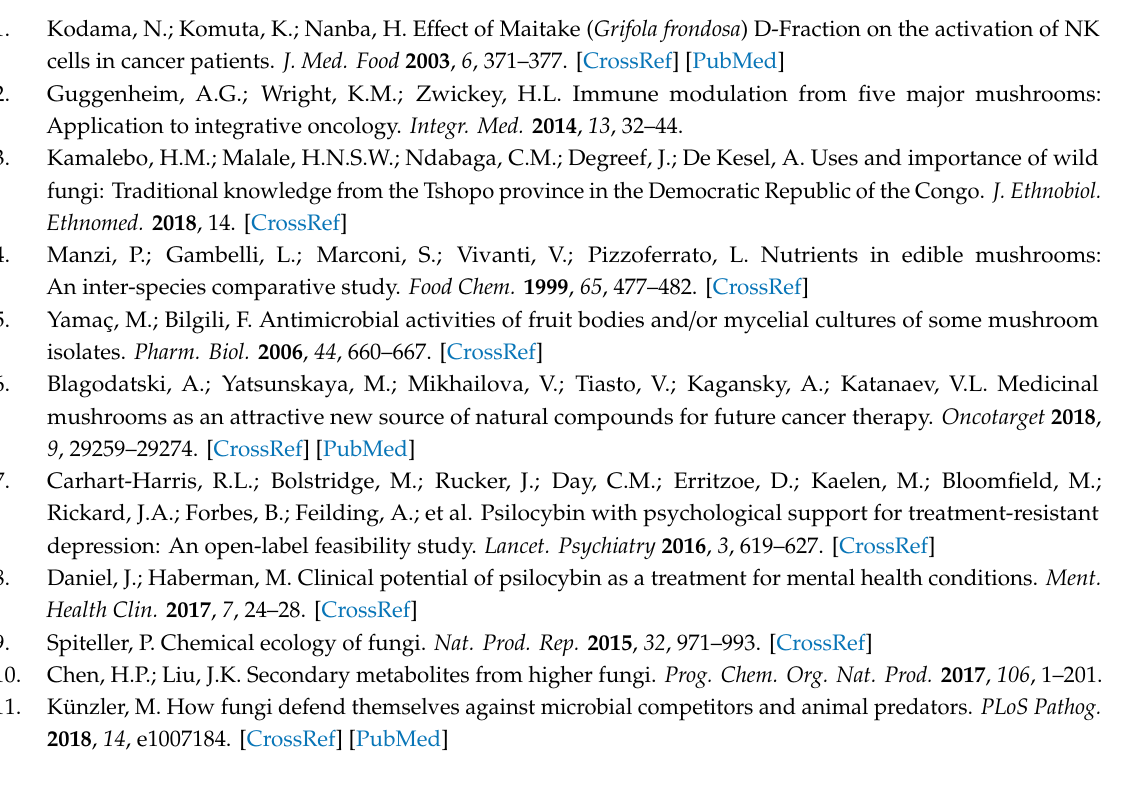
Figure S2: Flow diagram of extraction and isolation procedure of compounds 1 – 9 as described in detail in the Materials and Methods. Figure S3: 1 H NMR (400 MHz, CD 3 OD) spectrum of compound 1 . Figure S4: 13 C NMR (400 MHz, CD 3 OD) spectrum of compound 1. Figure S5 : DEPT135 NMR (400 MHz, CD 3 OD) spectrum of compound 1 . Figure S6: DEPT90 NMR (400 MHz, CD 3 OD) spectrum of compound 1 . Figure S7: 1 H- 13 C HSQC spectrum of compound 1 (400 MHz, CD 3 OD). Figure S8: 1 H- 13 C HMBC spectrum of compound 1 (400 MHz, CD 3 OD). Figure S9: 1 H- 1 H COSY spectrum of compound 1 (400 MHz, CD 3 OD). Figure S10: HRTOFMS spectrum of compound 1 . Figure S11: 1 H NMR (400 MHz, CD 3 OD) spectrum of compound 2 . Figure S12: 1 H NMR (400 MHz, CD 3 Cl 3 ) spectrum of compound 2 . Figure S13: 13 C NMR (400 MHz, CD 3 OD) spectrum of compound 2 . Figure S14: DEPT135 NMR (400 MHz, CD 3 OD) spectrum of compound 2 . Figure S15: DEPT90 NMR (400 MHz, CD 3 OD) spectrum of compound 2 . Figure S16: 1 H- 13 C HMQC spectrum of compound 2 (400 MHz, CD 3 OD). Figure S17. 1 H- 13 C HMBC spectrum of compound 2 (400 MHz, CD 3 OD). Figure S18. HRTOFMS spectrum of compound 2 . Table S1: Comparison of observed optical rotation of compound 2 with that of similar compounds. Table S2: MS, 1 H, and 13 C NMR data of known